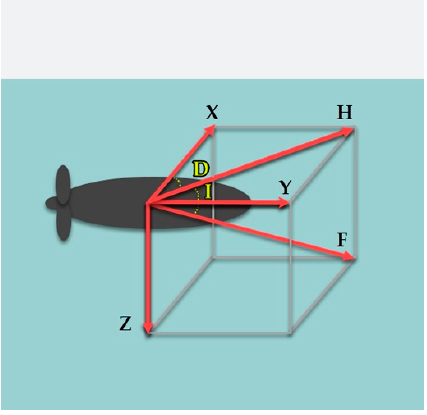
Figure 9. Geomagnetic map features.